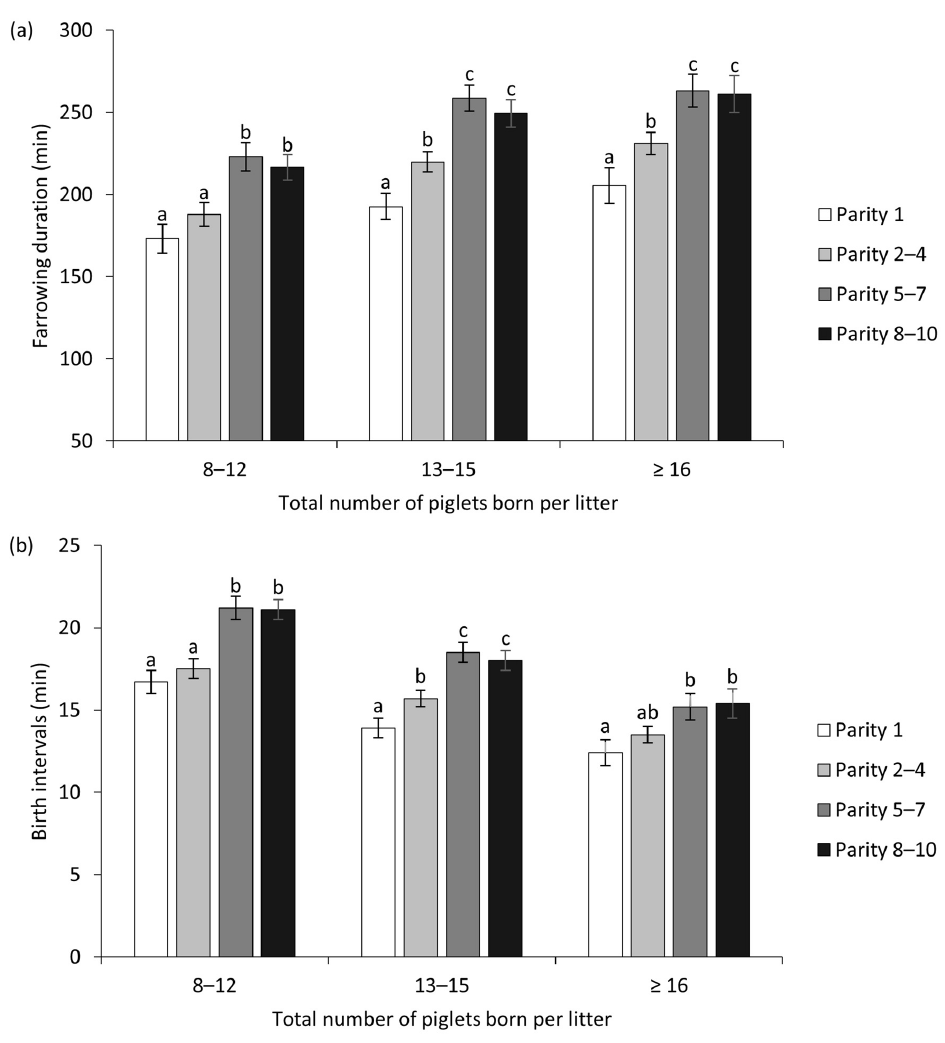
Figure 2. The duration of farrowing ( a ) and birth intervals ( b ) of sows among the total number of piglets born per litters and parities classes. a,b,c Different lowercase letters within the class of total number of piglets born per litter denote data that differ significantly ( p < 0.05). Bars indicate standard error.